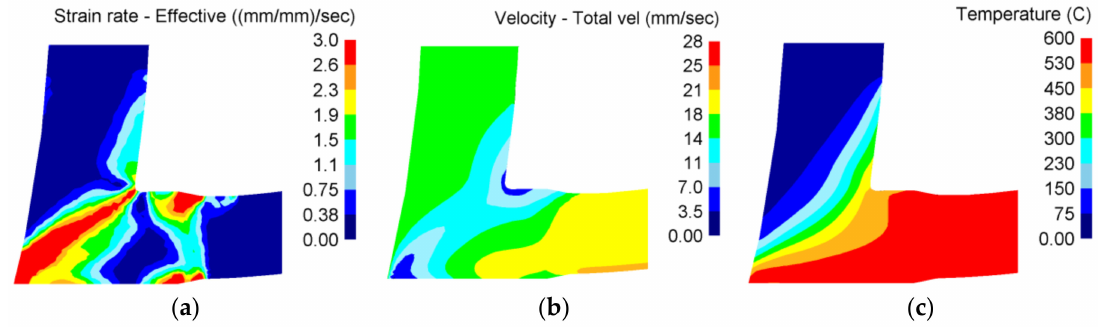
Figure 2. Numerical modelling of the Conform SPD process: ( a ) Strain rate distribution (s − 1 ); ( b ) Velocity distribution (mm/s); ( c ) Temperature distribution ( ◦